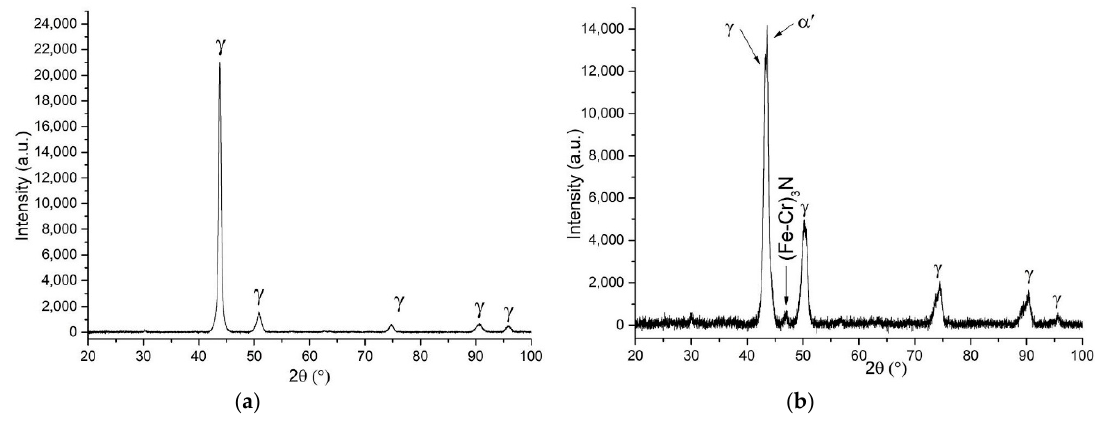
Figure 9. XRD patterns of the tested steel: ( a ) as-HIPped ( b ) HIPped and water quenched.